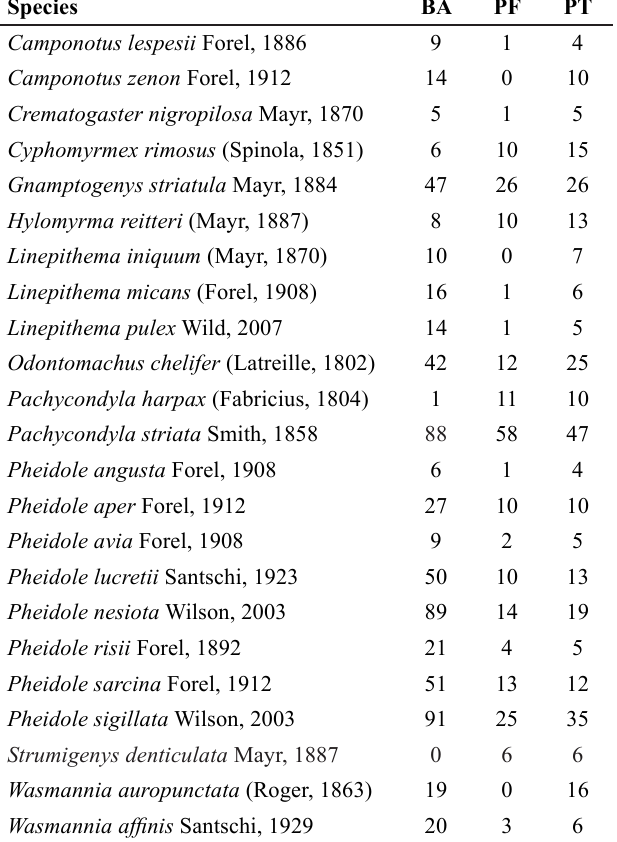
Table 2 – Species analyzed in this work. BA = total records in baits. PF = total records in pitfalls. PT = total records in sample points, considering both